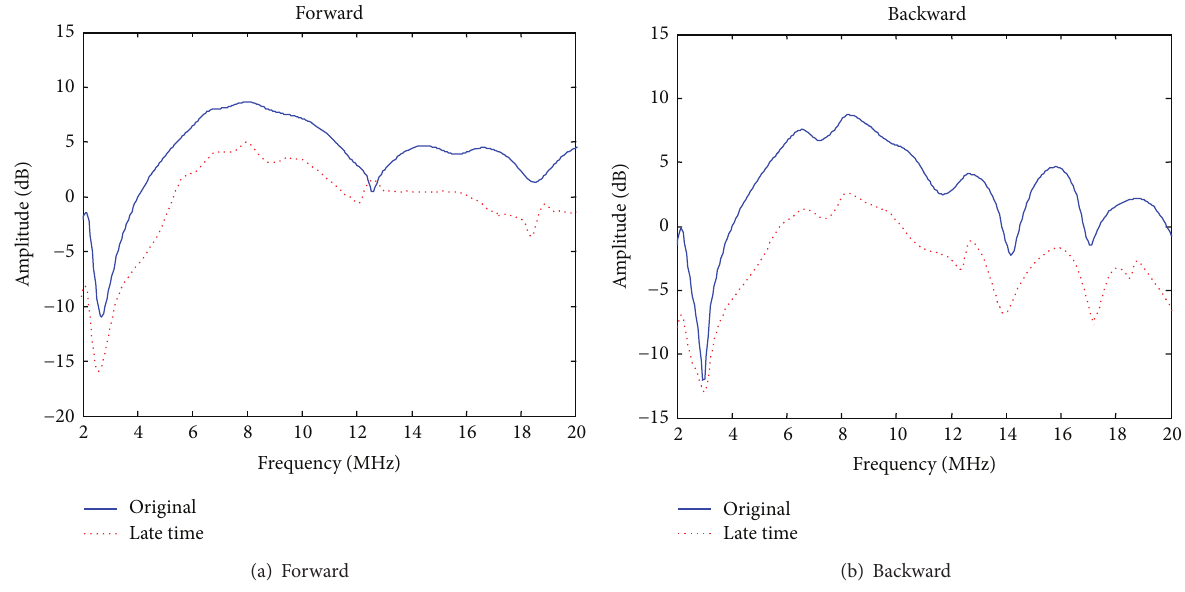
Figure 3: The comparison between original RCS and the RCS recovered only by late time response in frequency domain. (a) The angle between the incident and the bow is 0 ∘ . (b) The angle between the incident and the bow is 180 ∘ .